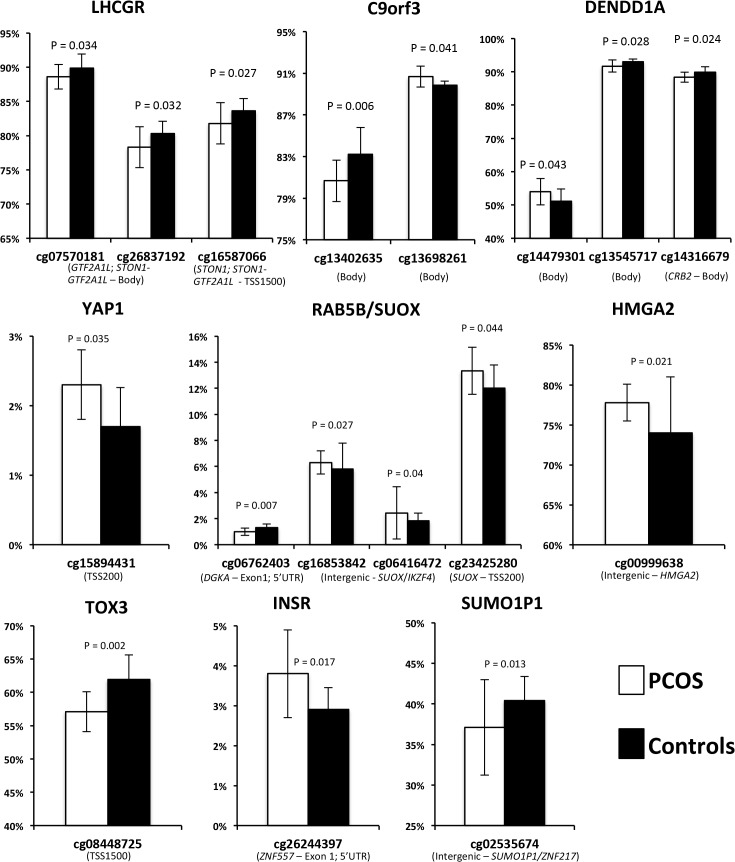
Methylation (Beta) levels at CpG sites with significantly different methylation between PCOS and controls.On the X axis are the significant CpG sites in the windows around the PCOS GWAS SNPs. On the Y axis is the methylation status, measured as the mean beta level. Error bars represent standard deviation.